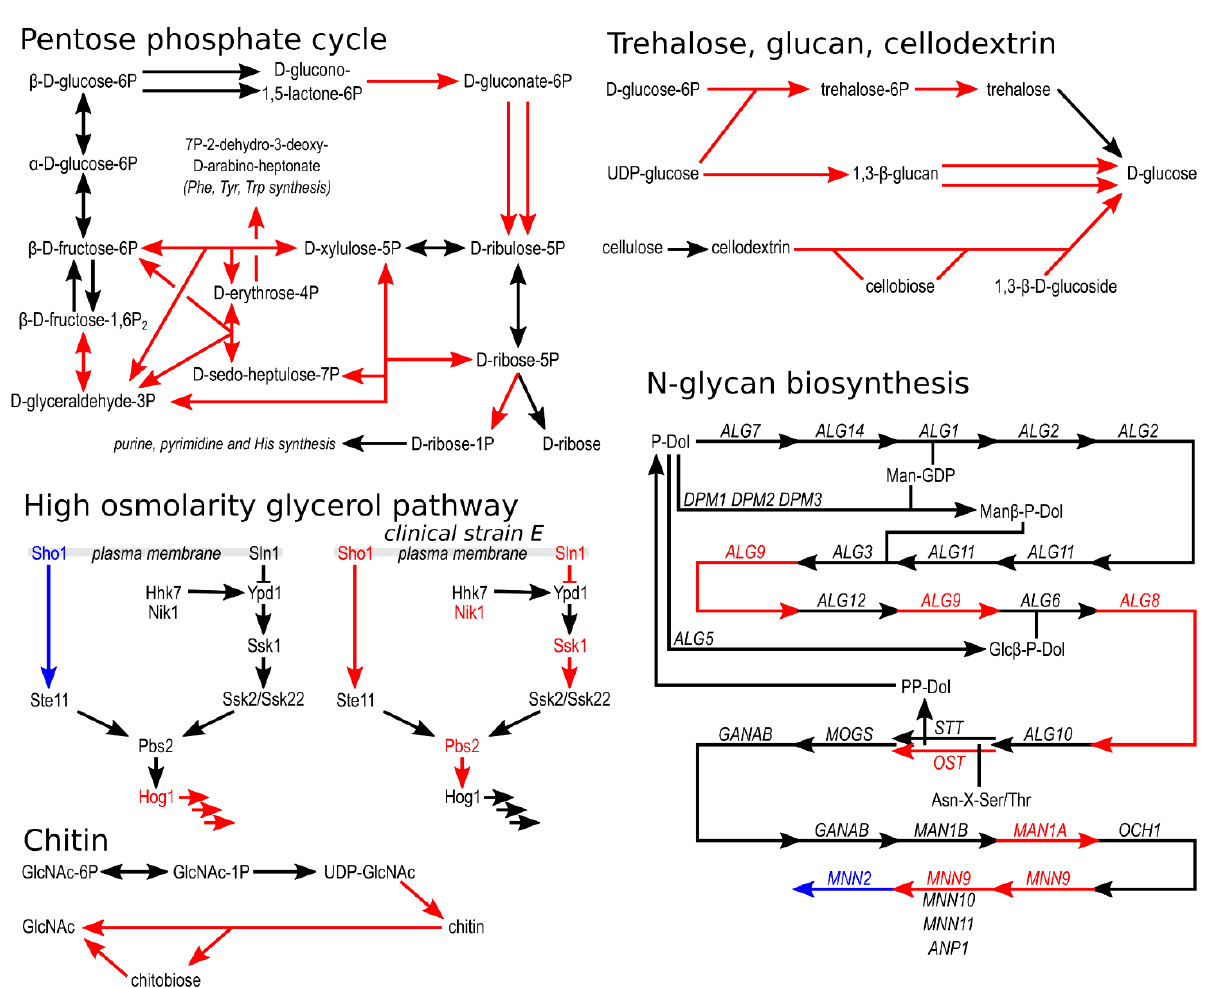
Figure 5. Schematic representation of selected metabolic pathways in Hortaea werneckii . Predicted proteins of the haploid reference H. werneckii genome were assigned to KEGG pathways. These were redrawn to show selected pathways. Arrows mark enzymatic reactions with putative enzymes identified in H. werneckii . The presumed ploidy of the genomic region with the gene for a particular enzyme is indicated by the colour of the arrow and the name of the gene/protein: diploid in black, triploid in red, haploid in blue. If a particular enzyme is coded by genes in more than one locus, at least one of these loci had to be in aneuploid regions of at least one of the evolved strains to be marked with red or blue.